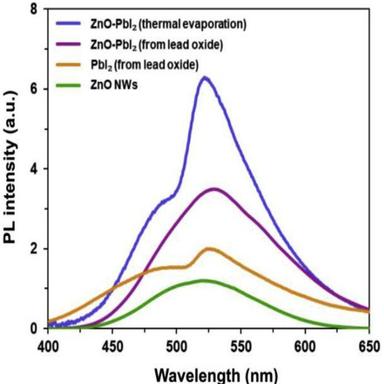
Room temperature photoluminescence (PL) spectra at 266 nm excitation wavelength for the different as-prepared samples. The PL intensity is depicted in arbitrary units and does not contain information about relative intensities between the measured spectra.